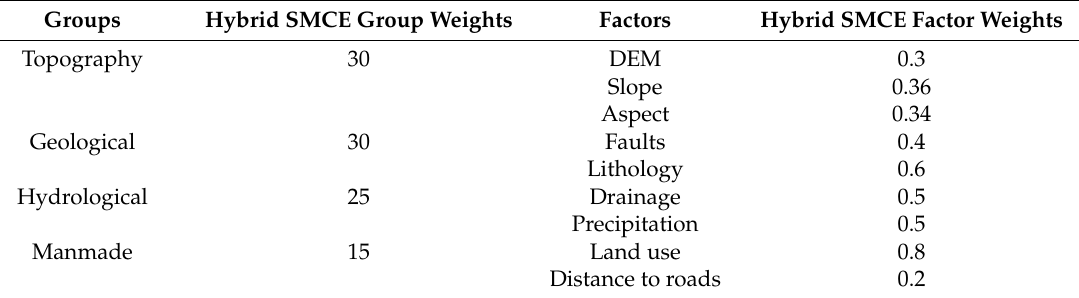
Table 3. Weights for groups and factors based on the hybrid SMCE